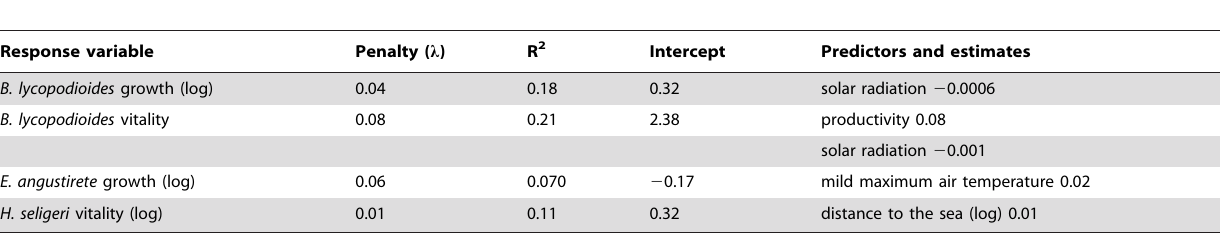
Table 3. Optimal lasso regression models of effects of environmental variables on the performance variables growth of